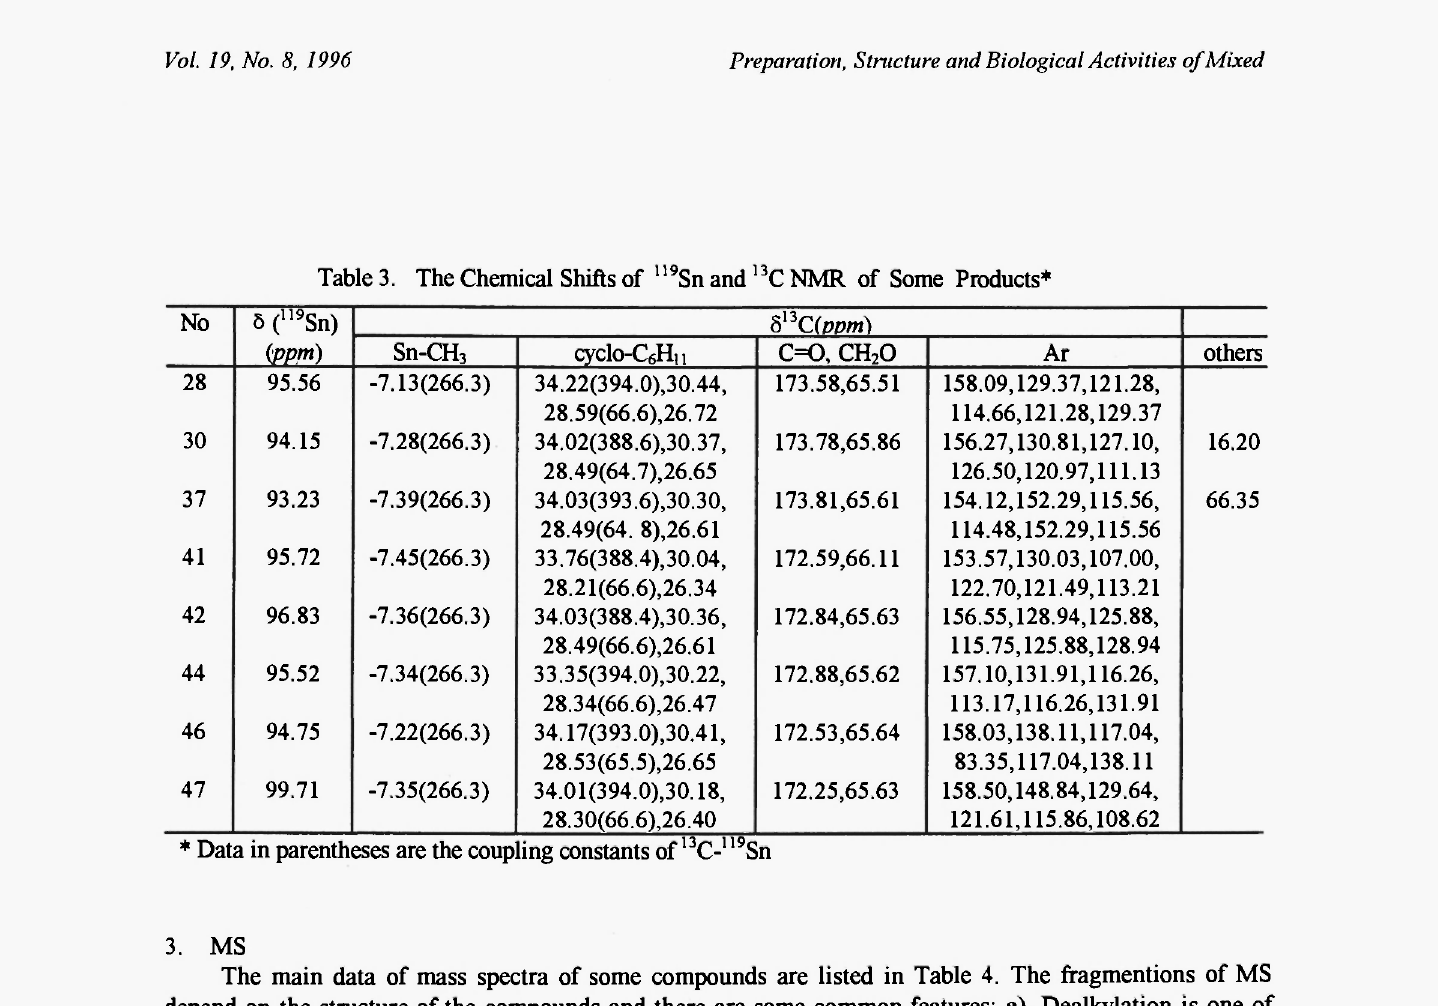
Table 3. The Chemical Shifts of U9 Sn and 13 C NMR of Some